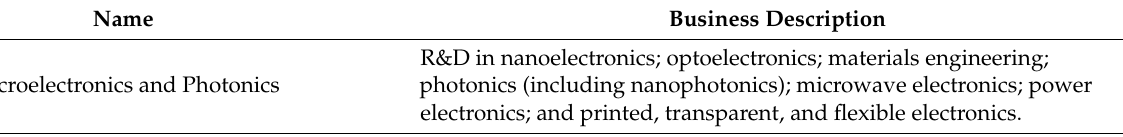
Table 1. Characteristics of researched institutes in digital transformation